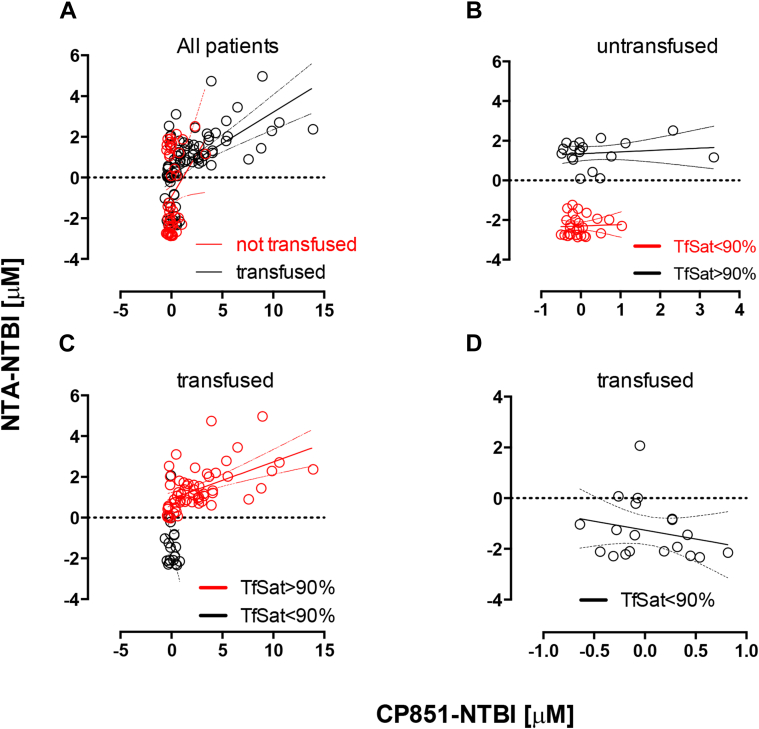
The effect of transferrin saturation on method agreement in transfused and untransfused patients. (A) Plot of both NTBI methods in transfused (black) and untransfused patients (red). (B) Plot of both NTBI methods in untransfused patients (red in panel A). Samples with TfSat>90% are now shown in red and those with TfSat<90% in black. (C) Both NTBI methods plotted in transfused patients (black in panel A), here further grouped according to TfSat in sample: with significant slope in TfSat>90% (red, P < 0.0001) and insignificant in TfSat<90% (black). (D) Both methods plotted for transfused patients with TfSat <90% show insignificant slope (black symbols from panel E magnified). TfSat, transferrin saturation; NTBI, nontransferrin-bound iron.